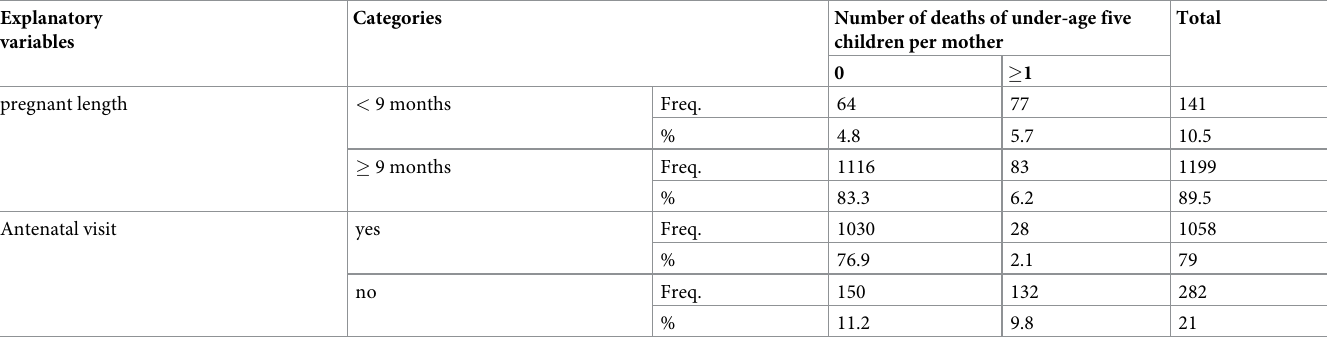
Based on the data, the Deviance statistics (176.985) and Pearson Chi-square statistic (248.909) divided by their corresponding degrees of freedom (1313) are less than one, respec- tively. This implies there is no over-dispersion. So Poisson model is the most appropriate model as compared to the negative binomial model. In addition, the fact that the Likelihood ratio test of α statistic, LRT = -2(Log-likelihood of Poisson–Log-likelihood of NB) = -2 α (-262.227 + 262.227) = 0. The value of the likelihood-ratio test of dispersion parameter alpha was 0 with p- value of 0.499 which demonstrated that there is an no over dispersion in our data because the p-value is greater than the level of significance (0.05) that means failing to reject the null hypothesis ( α = 0). P-value of LRT α > level of significance implies Poisson regression is preferred as compared to NB. We cannot proceed with the negative binomial and zero-inflated negative binomial regression models due to no over-dispersion. But we used ZIP regression model because it has an excess zeros (Table 3).